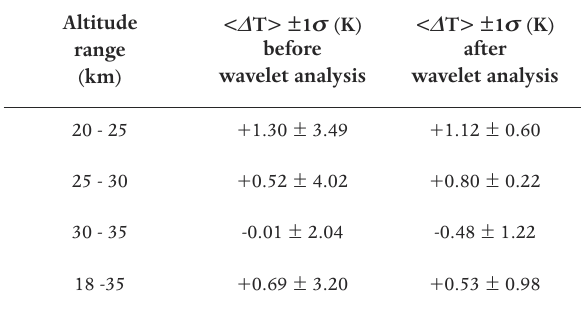
Table 2. Comparison of the temperature difference distribution computed as the mean value and standard deviation of < D T > over each altitude range before and after applying the wave screening technique to the temperature profiles measured by GOMOS and SHADOZ over Ascension for October 11, 2004, illustrated in Fig- ure 2 and Figure